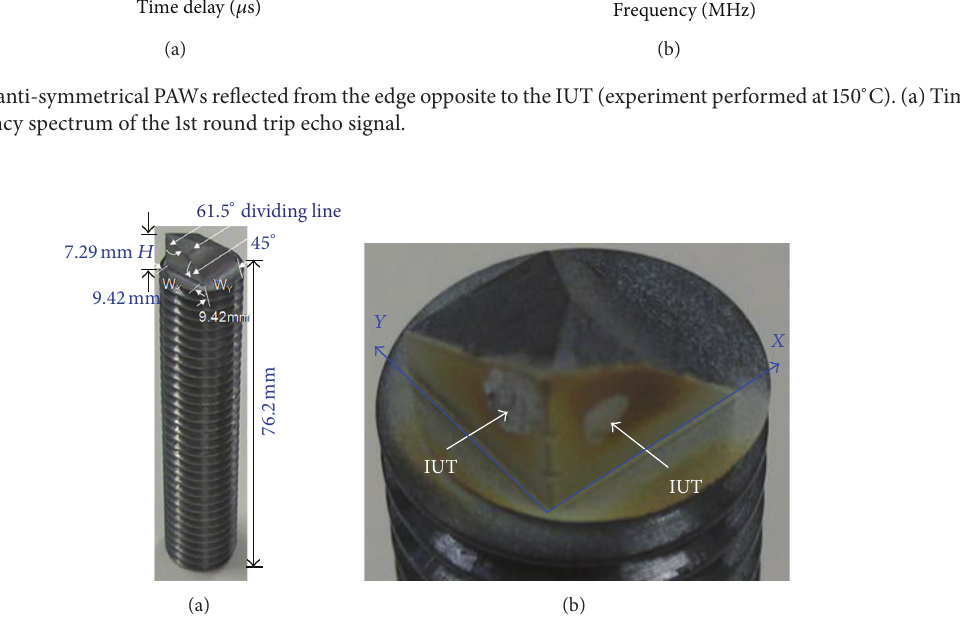
Figure 18: (a) An integrated probe which can generate and receive longitudinal and two orthogonal shear waves. (b) Probe head having two